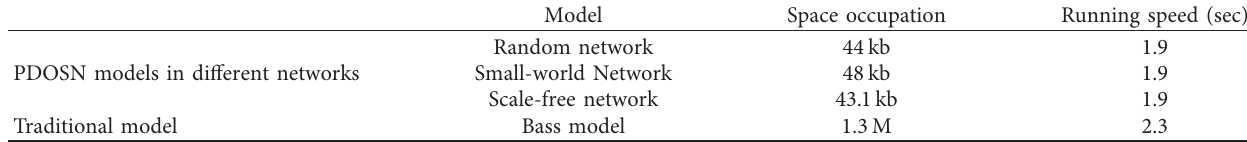
Table 6: Computational complexity